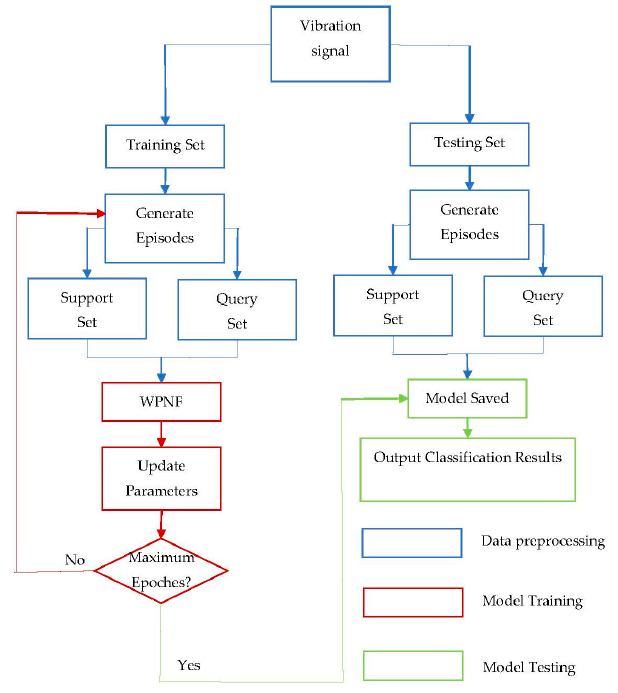
Figure 5. Flowchart of model training.